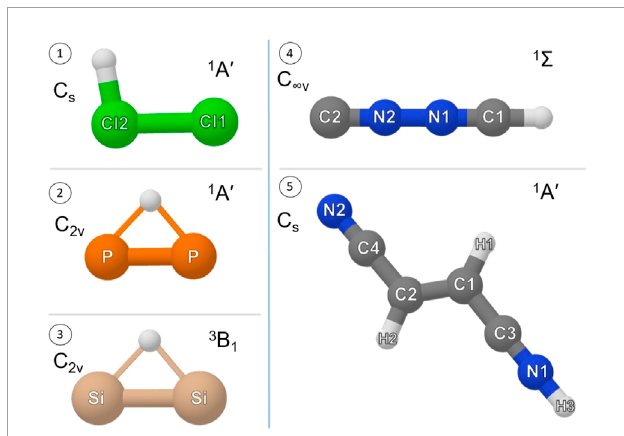
FIGURE 1 Equilibrium structure, point group symmetry and electronic ground state of (1) Cl 2 H + , (2) HP 2 + , (3) HSi 2 + , (4) CNNCH + , and (5) protonated ( E